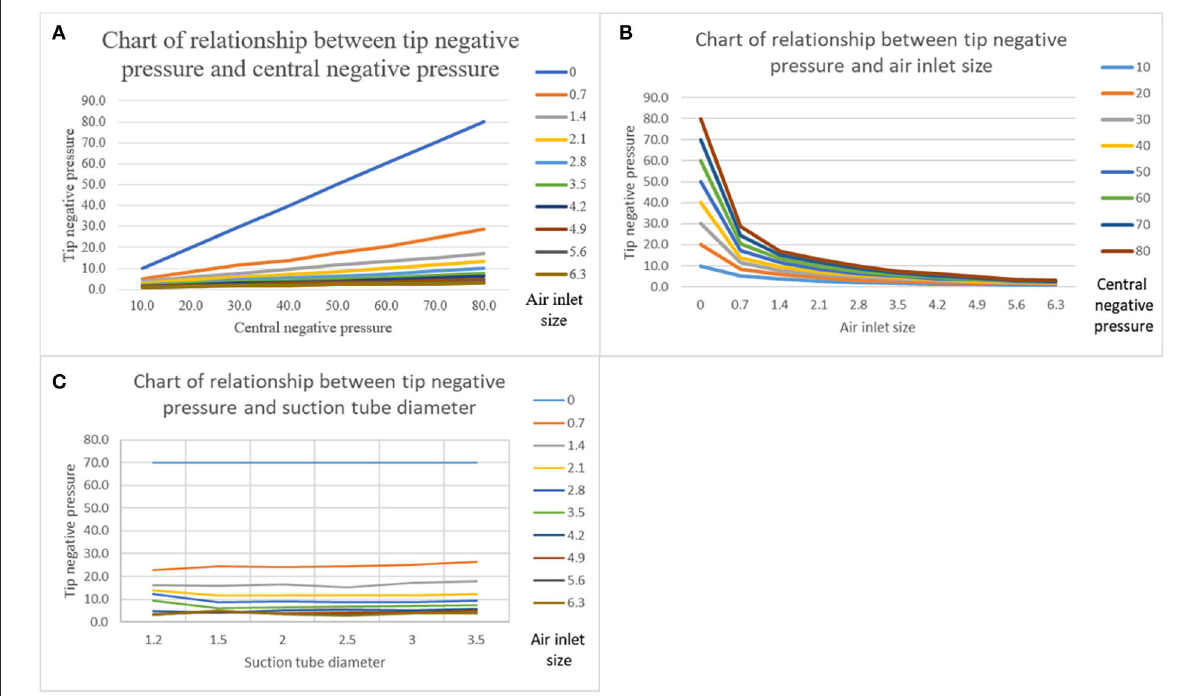
FIGURE6 (A) A chart showing the relationship between the tip negative pressure and central negative pressure. Suction tube diameter was 2.5mm. (B) A chart showing the relationship between the tip negative pressure and the air inlet size. Suction tube diameter was 2.5mm. (C) Chart showing the relationship between the tip negative pressure and suction tube diameter. Central negative pressure was 70 kPa.